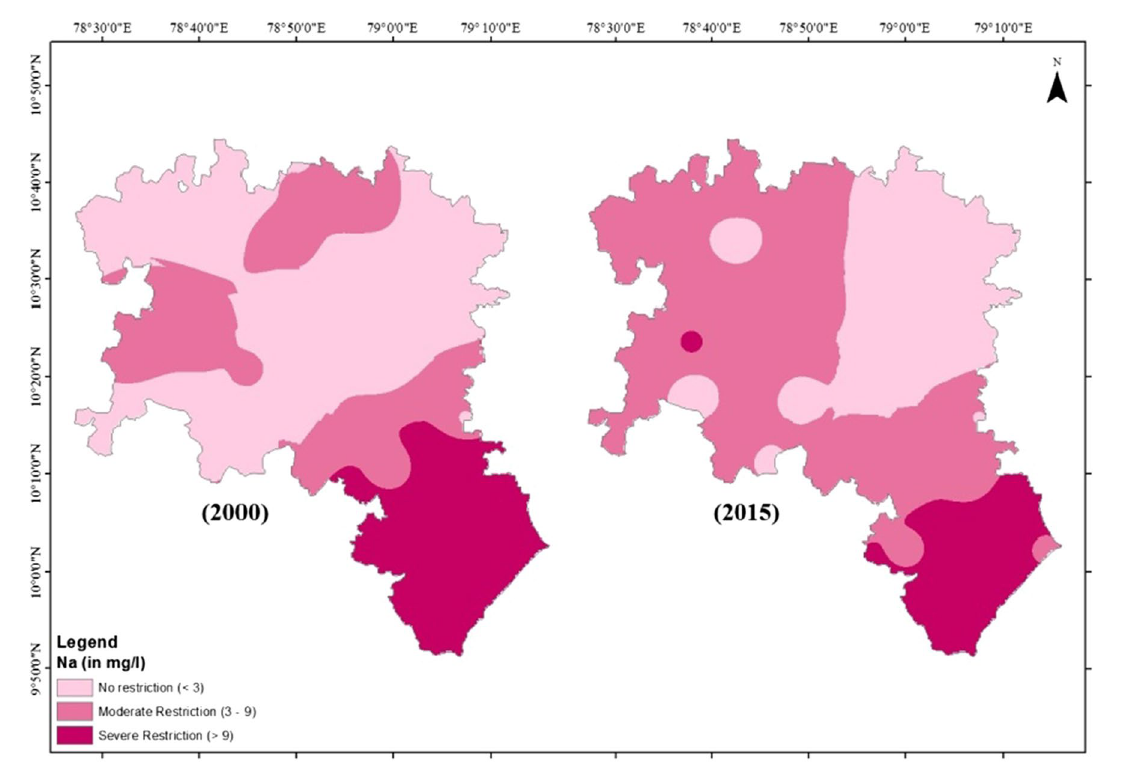
Fig. 5 Spatial distribution of sodium (2000 and